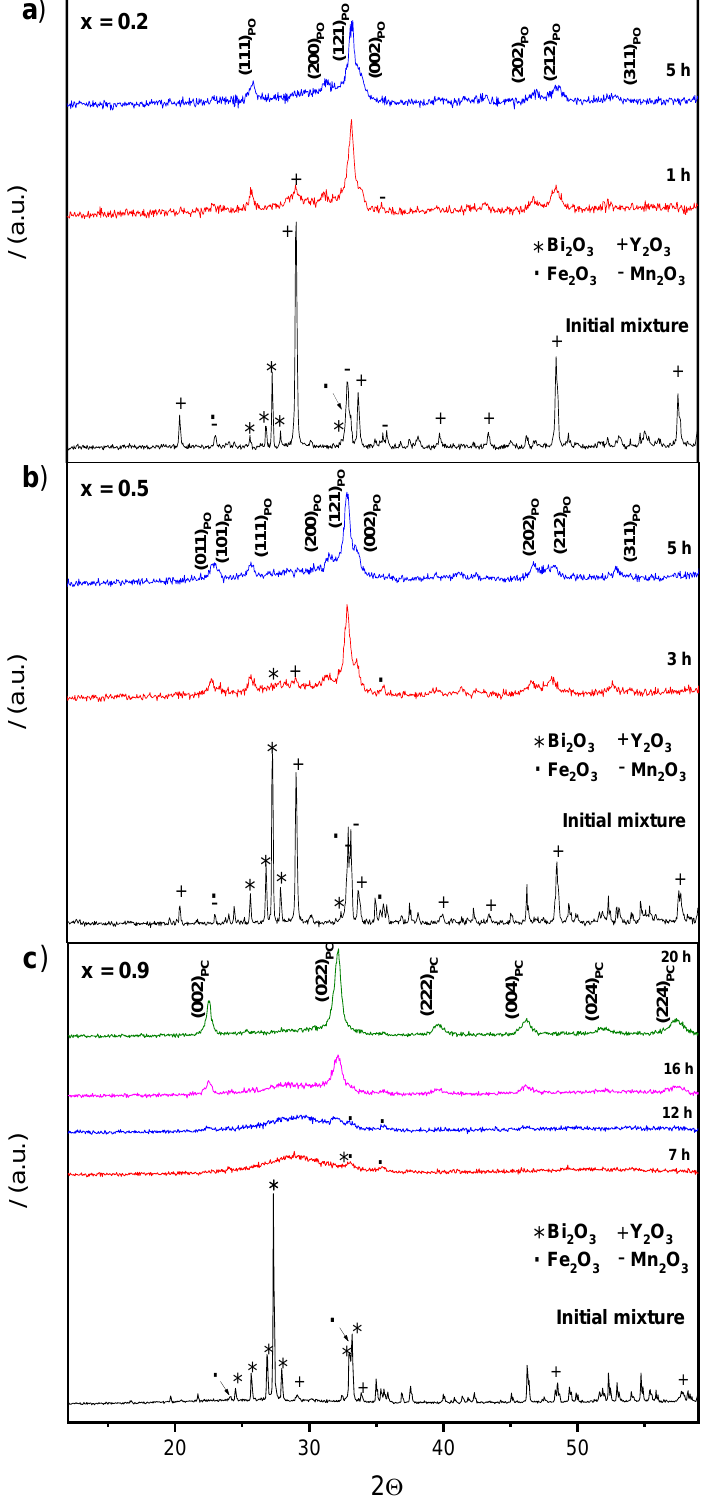
Figure 1. Evolution with the milling time of the stoichiometric mixture of reactants corresponding to Y 1−x Bi x Mn 1−x Fe x O 3 for compositions: ( a ) x = 0.2; ( b ) x = 0.5; and ( c ) x = 0.9 (PC — Pseudocubic Perovskite; PO — Pseudo-orthorhombic Perovskite).